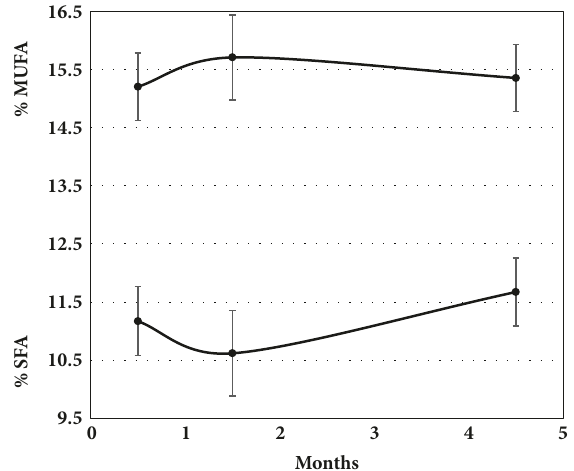
Figure 7: Average mass percentages ( ± 1 SE) of monounsaturated and saturated fatty acids, calculated from the ATR-FTIR